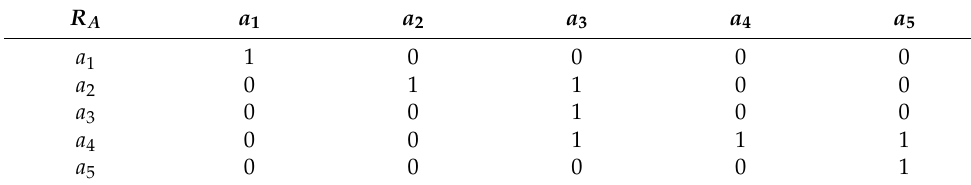
Table 2. The binary relation R A on A